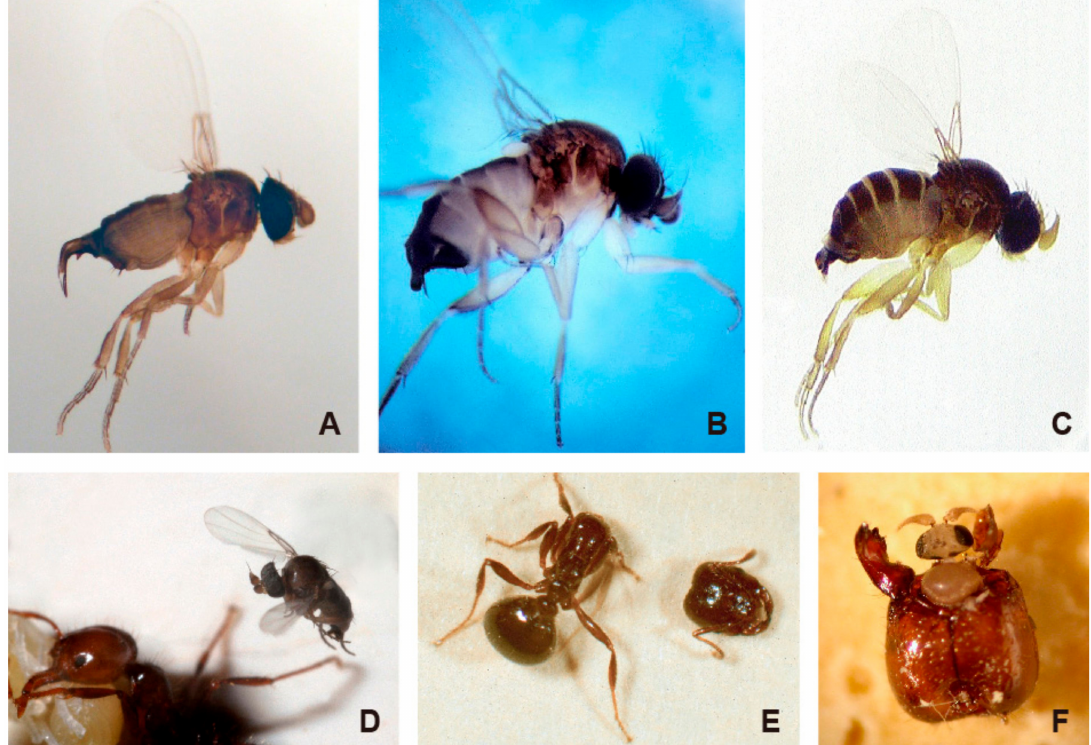
Figure 1. Decaptating phorid flies with specialized ovipositors and their parasitic life cycle. ( A ) Pseudacteon curvatus female; ( B ) Pseudacteon nocens female; ( C ) Pseudacteon obtusus female; ( D ) Female Pseudacteon litoralis fly preparing to inject an egg into the thorax of a fire ant worker; ( E ) Fire ant worker decapitated by a fly maggot just prior to pupariation; ( F ) A P. litoralis male fly emerging from the head capsule of a parasitized fire ant